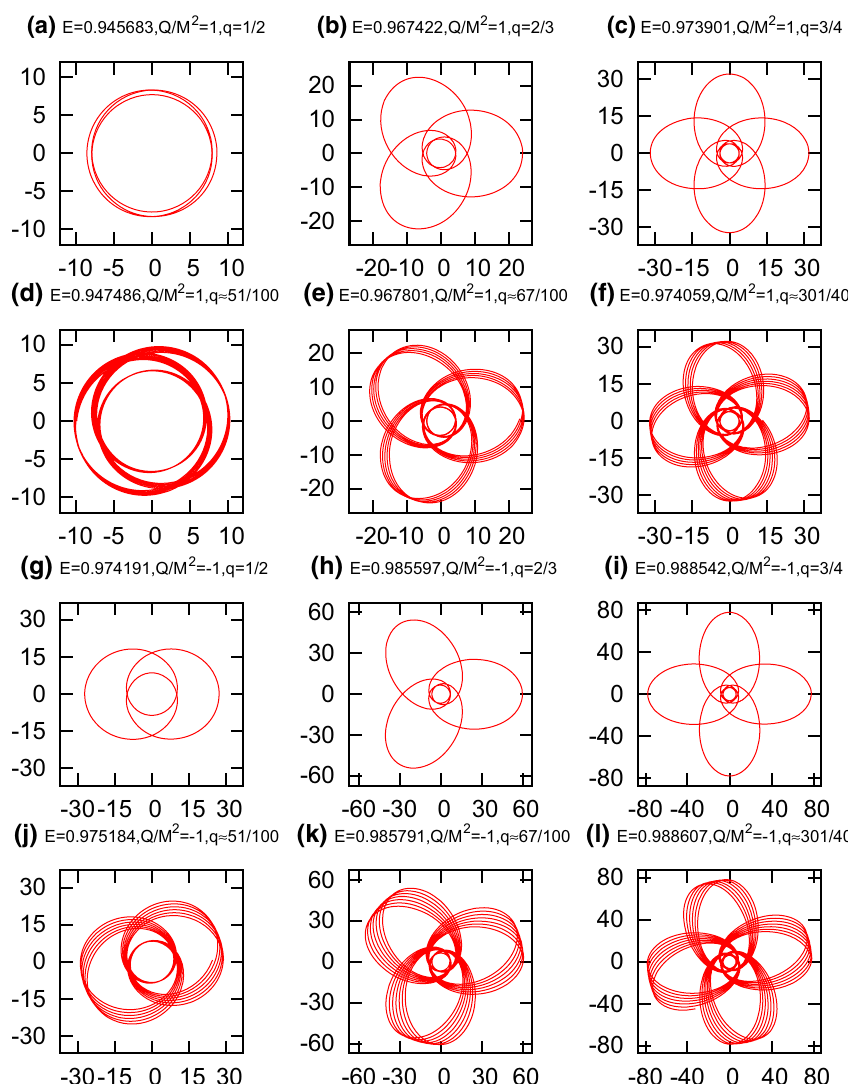
Fig. 10 Periodic orbits with rational numbers (rows 1 and 3) and nearby aperiodic orbits with approximate rational numbers (rows 2 and 4) with (cid:14) = 0 . 9